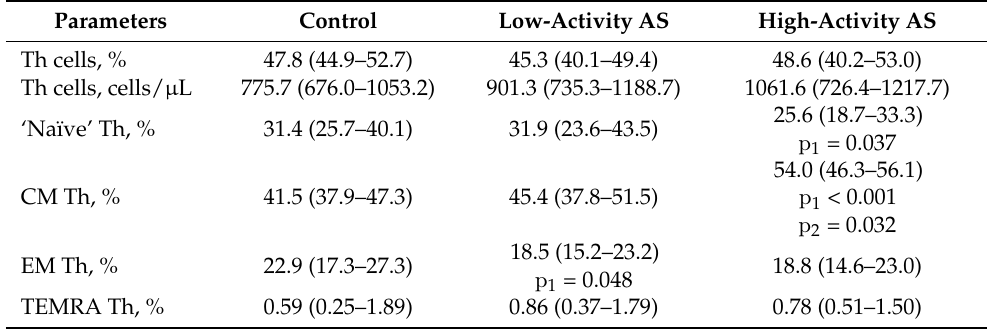
Table 1. Peripheral blood Th-cell subset composition in activity-driven AS patients ( Ме (IQR)). Parameters Control Low-Activity AS High-Activity